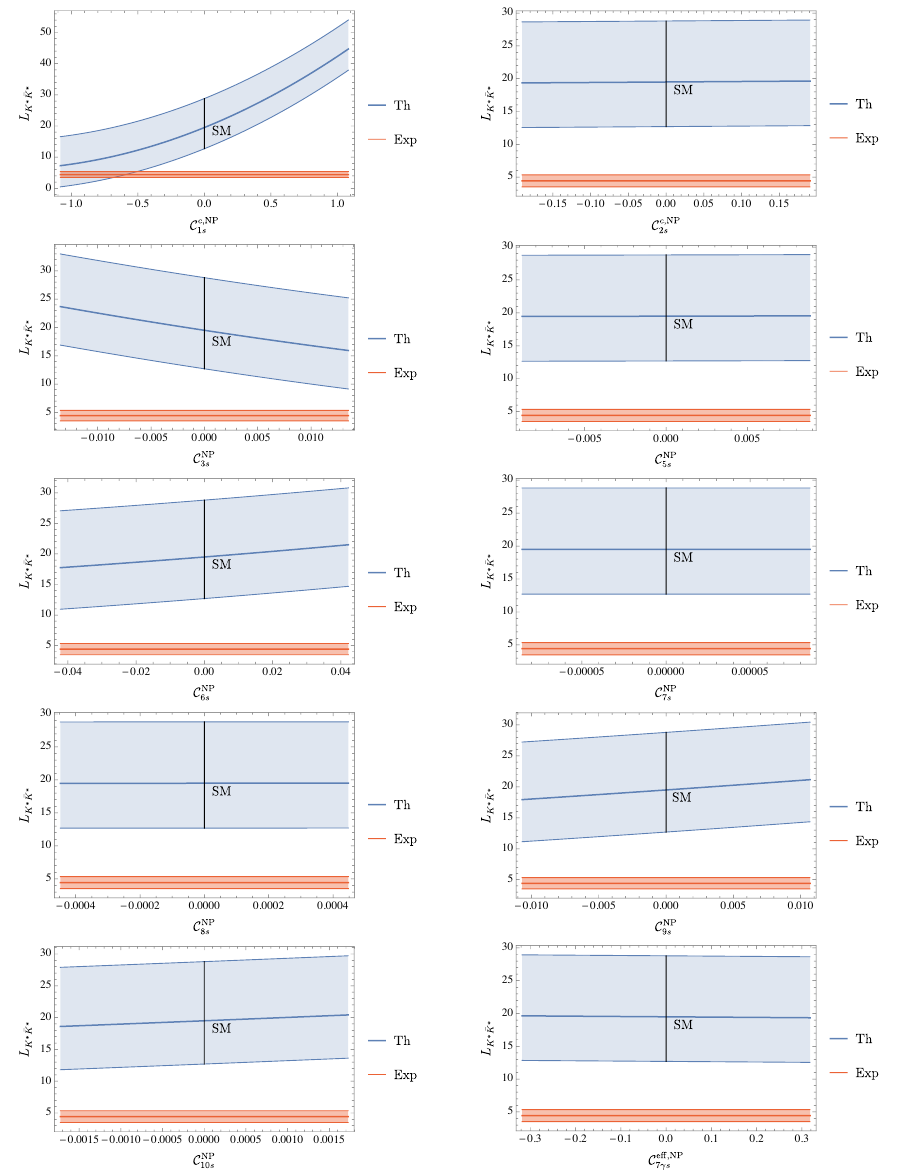
Figure 4 . 1 σ intervals for the NP contribution to Wilson coefficients needed to explain L normalised to their SM value.